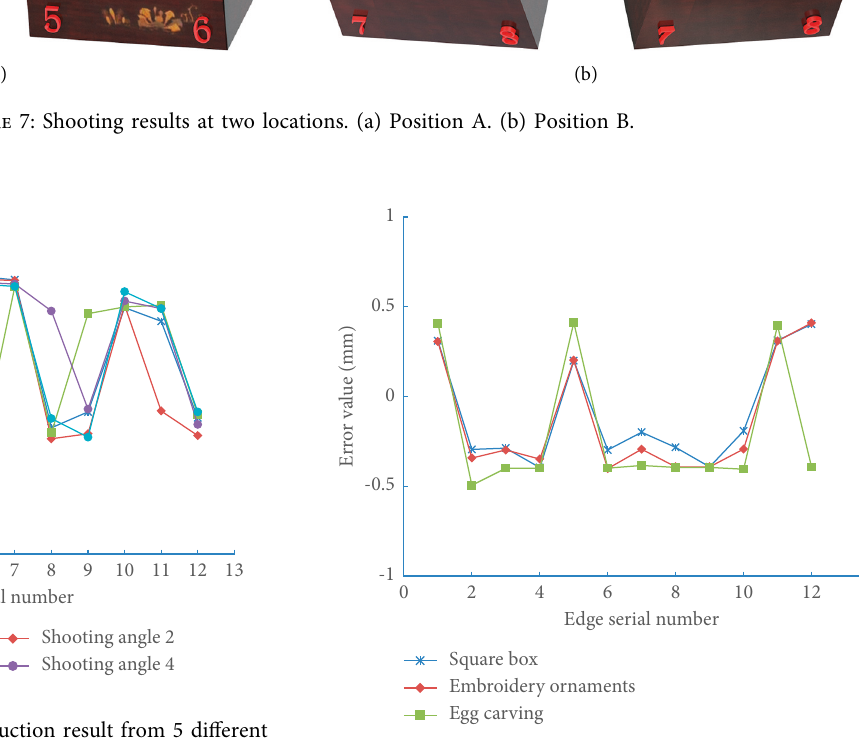
Figure 10: Error of reconstruction result.